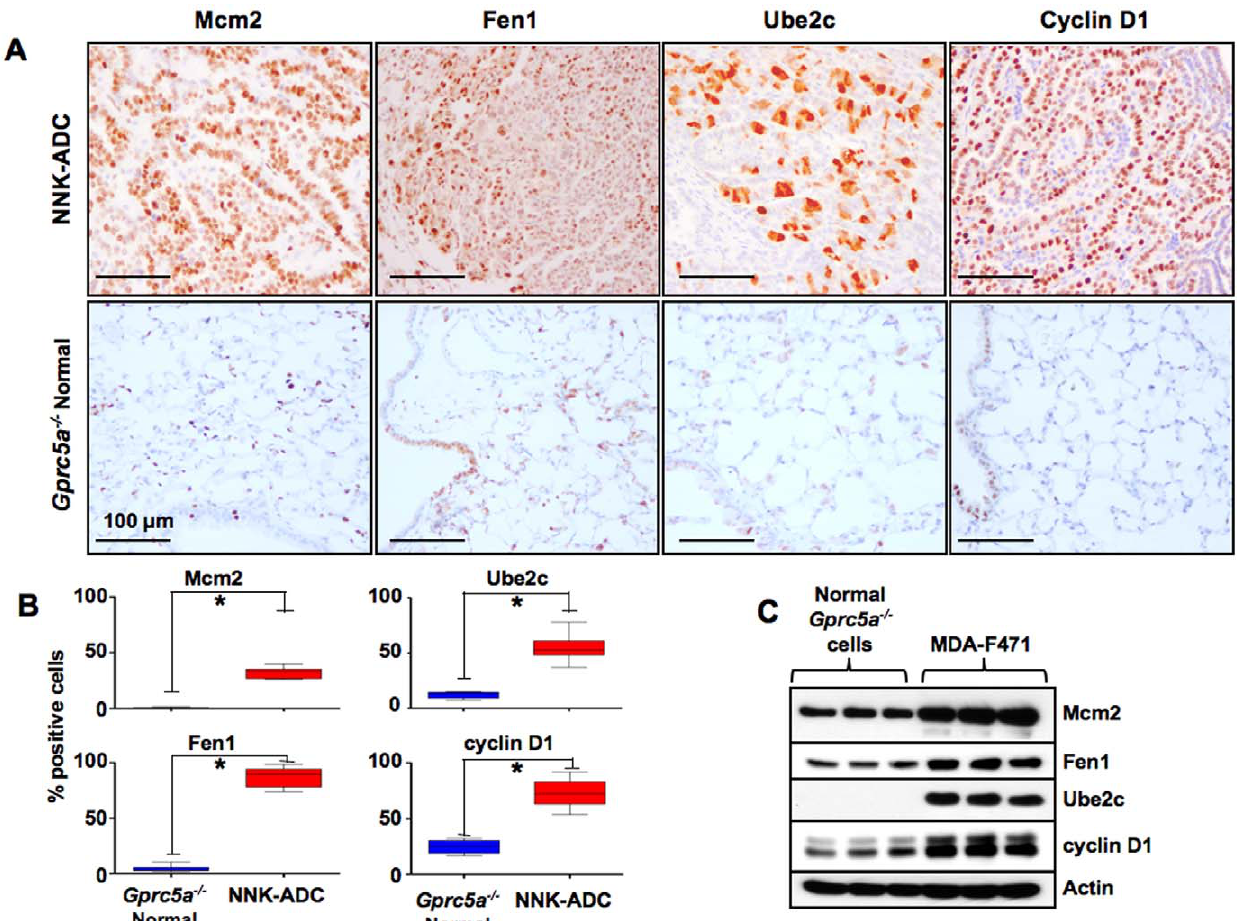
Figure 7. Elevated expression of Ube2c, Mcm2, Fen1 and cyclin D1 proteins in Gprc5a -knockout adenocarcinomas and normal lung tissue and cells. A . Representative photomicrographs depicting increased expression of the protein products of Mcm2, Ube2c, Fen1 and cyclin D1 in NNK-induced adenocarcinomas and normal lung histological tissue specimens obtained from NNK-exposed Gprc5a -knockout mice. All four proteins exhibited mainly nuclear localization of expression. B . The number of cells exhibiting positive reactivity (nuclear staining) was counted in up to three separate microscopic fields per tumor or normal lung in five different NNK-exposed Gprc5a 2 / 2 mice. P-values were obtained by the students two-sample t -test (*, p , 0.001). C . Western blotting analysis of the four antigens in three different culture dishes of each of the Gprc5a 2 / 2 MDA-F471 adenocarcinoma and normal lung cells. Approximately 10 6 cells per 10 cm cell culture dish were harvested to prepare total protein extracts. Samples of these extracts (20 m g protein) were analyzed by western blotting using primary antibodies against the indicated proteins. Membrane blots were also analyzed with antibodies against b -actin to compare protein loading in the different lanes.